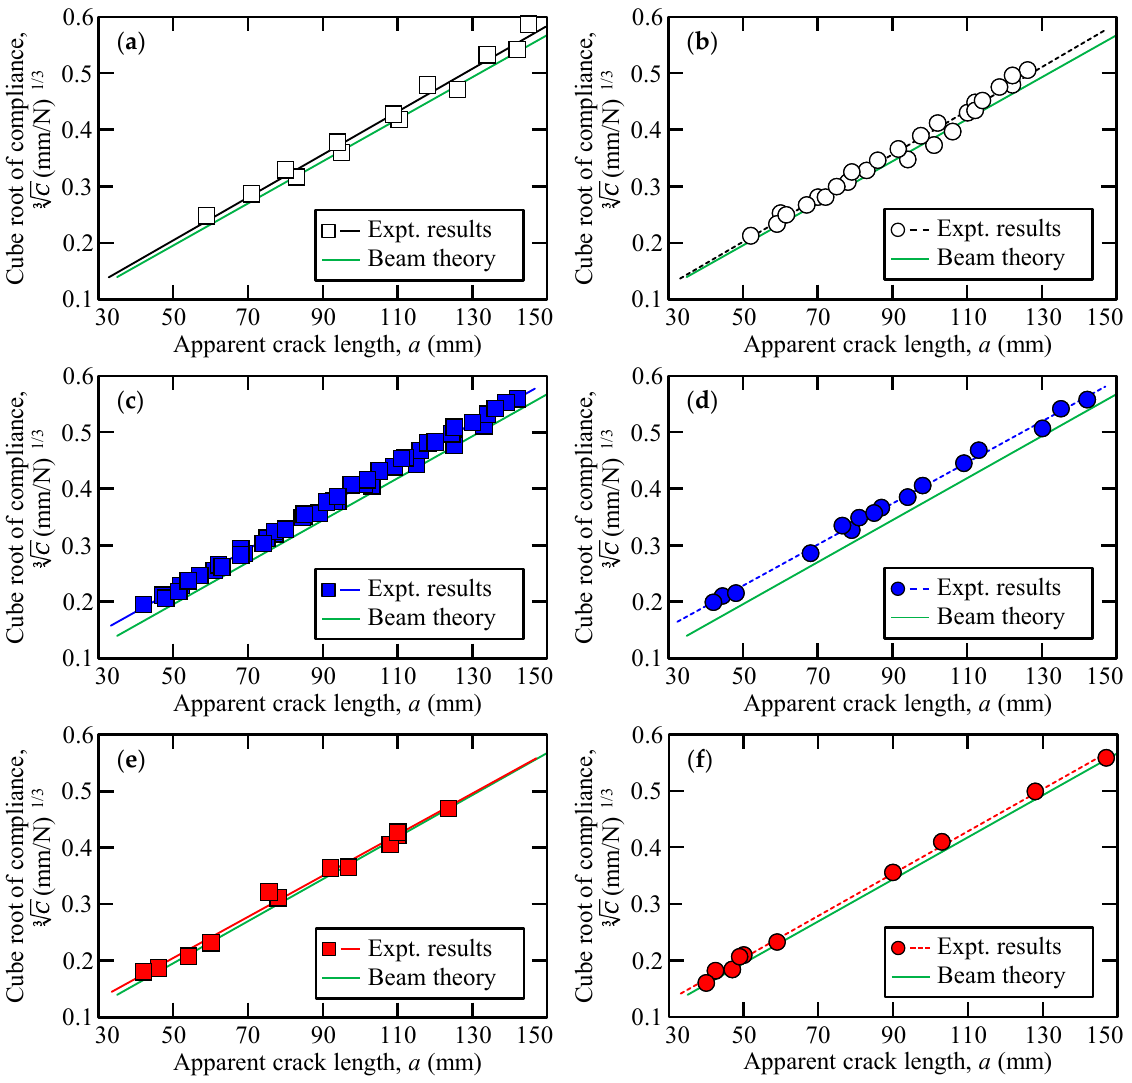
Figure 9. Relationship between the apparent crack length and the cube root of compliance of ( a ) 0.3 mm thickness of Y618H, ( b ) 3.0 mm thickness of Y618H, ( c ) 0.3 mm thickness of Metal Lock, ( d ) 3.0 mm thickness of Metal Lock, ( e ) 0.3 mm thickness of Y611 Black S, and ( f ) 3.0 mm thickness of Y611 Black S.